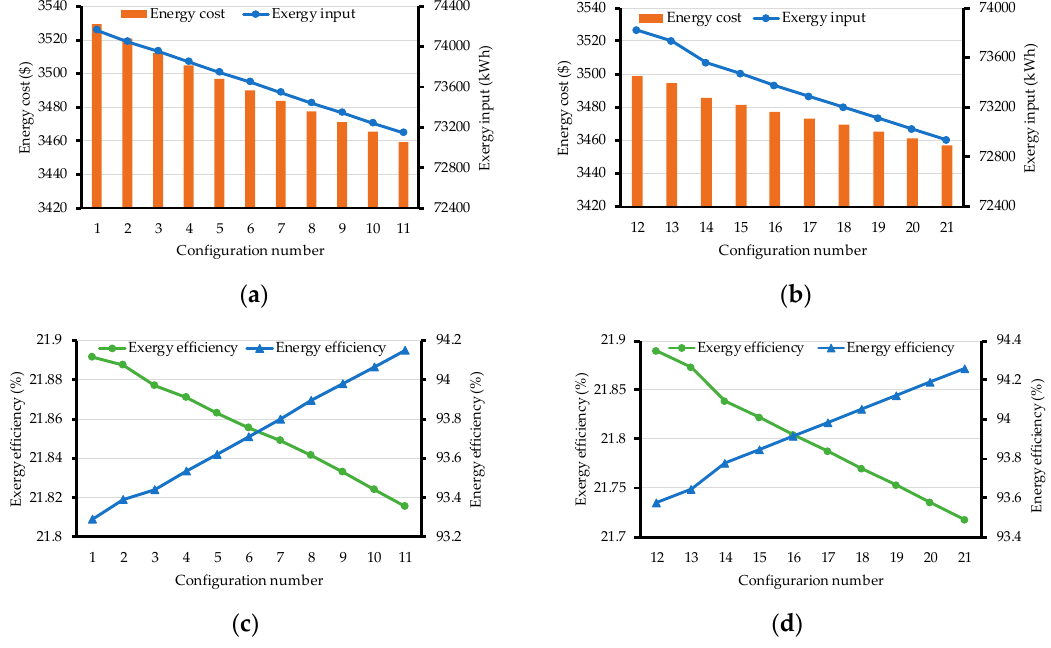
Figure 16. Energy cost, exergy input, exergy efficiency and energy efficiency for each configuration. ( a ) Energy cost and exergy input for Configurations 1–11; ( b ) energy cost and exergy input for Configurations 12–21; ( c ) exergy efficiency and energy efficiency for Configurations 1–11; ( d ) exergy efficiency and energy efficiency for Configurations 12–21.